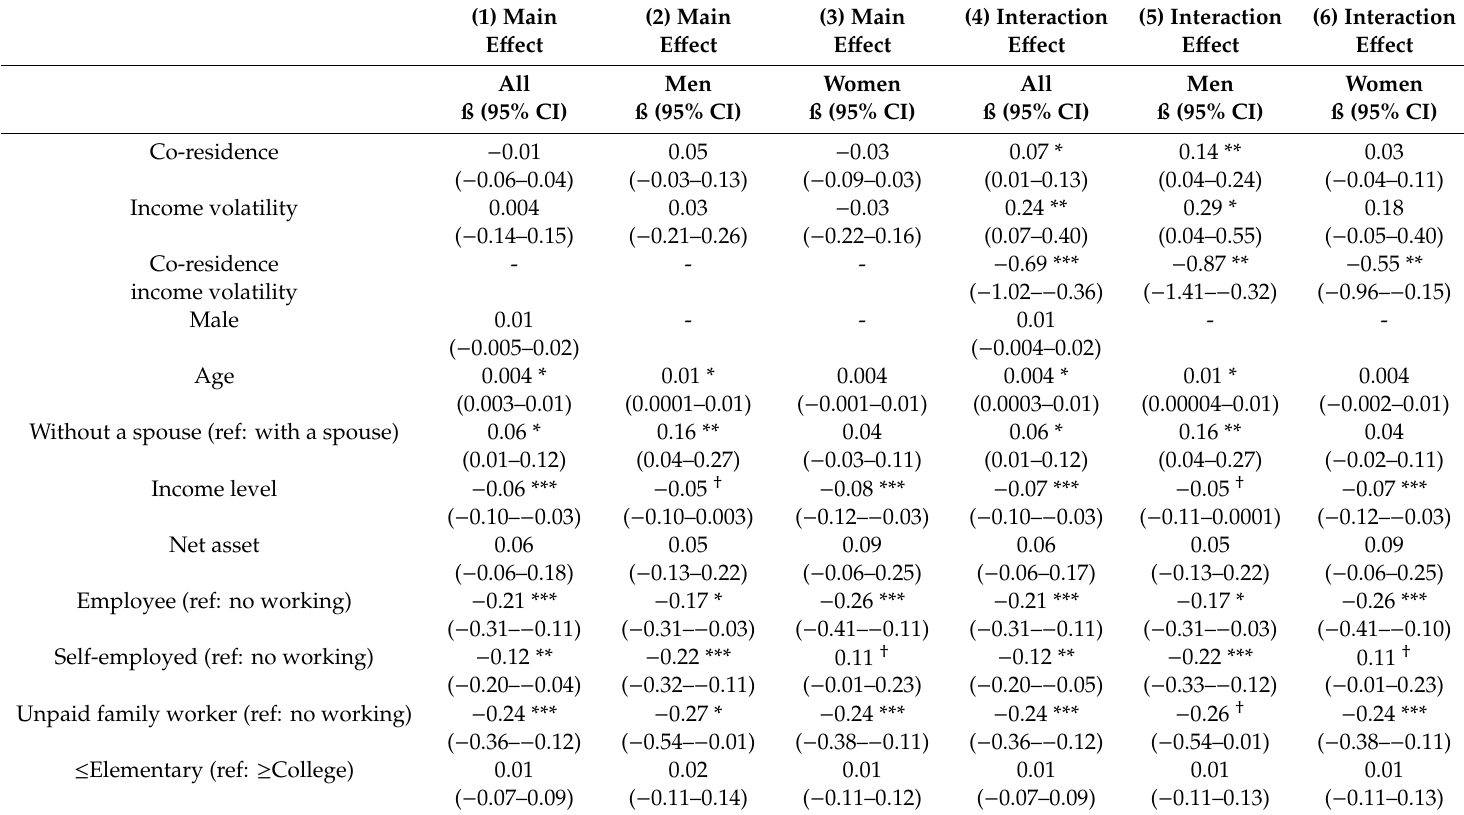
Table 2. The relationships of income volatility to depressive symptoms (CES-D 10